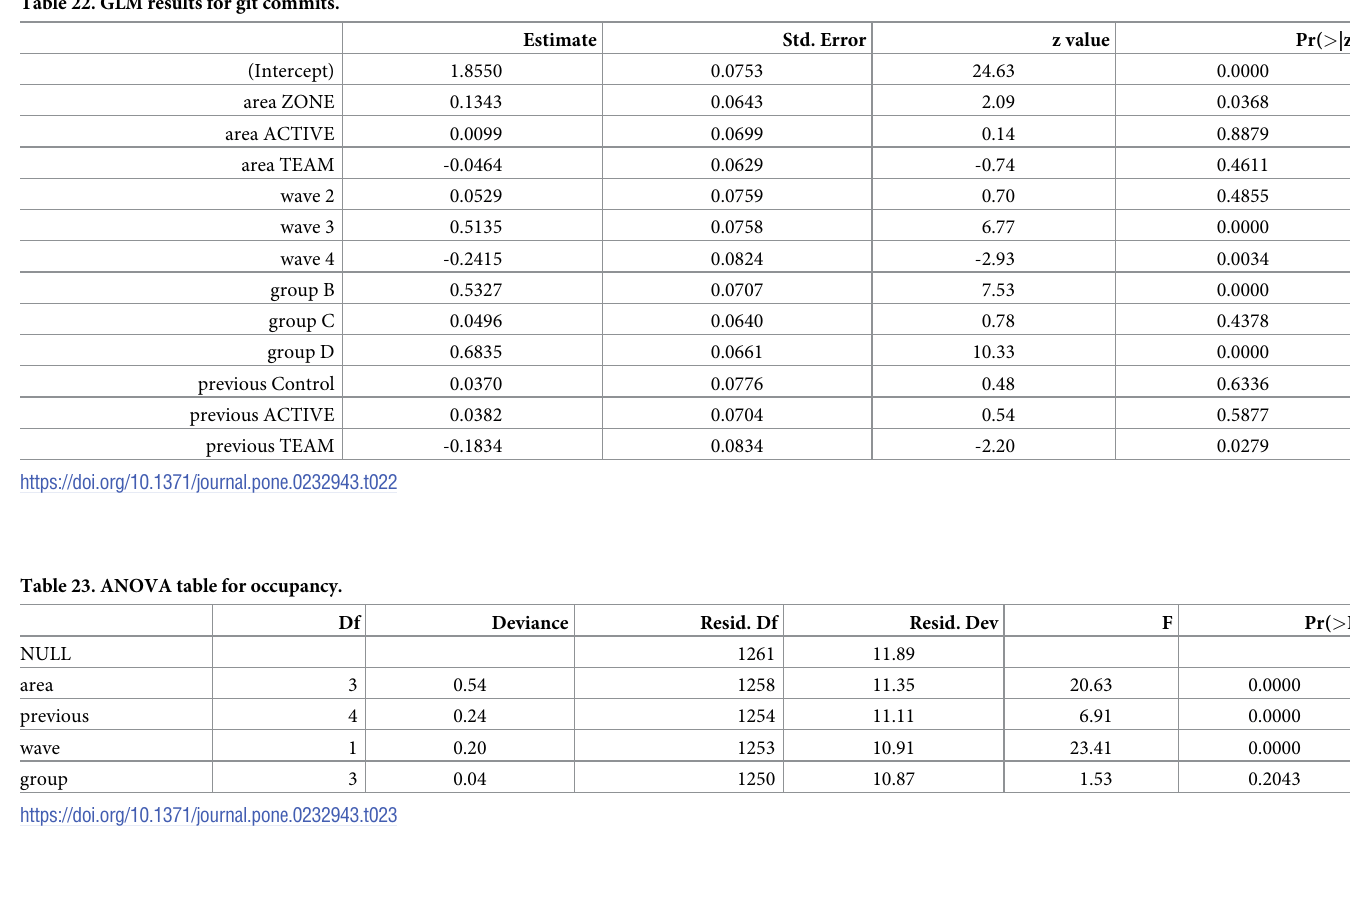
Table 24. GLM results for occupancy.